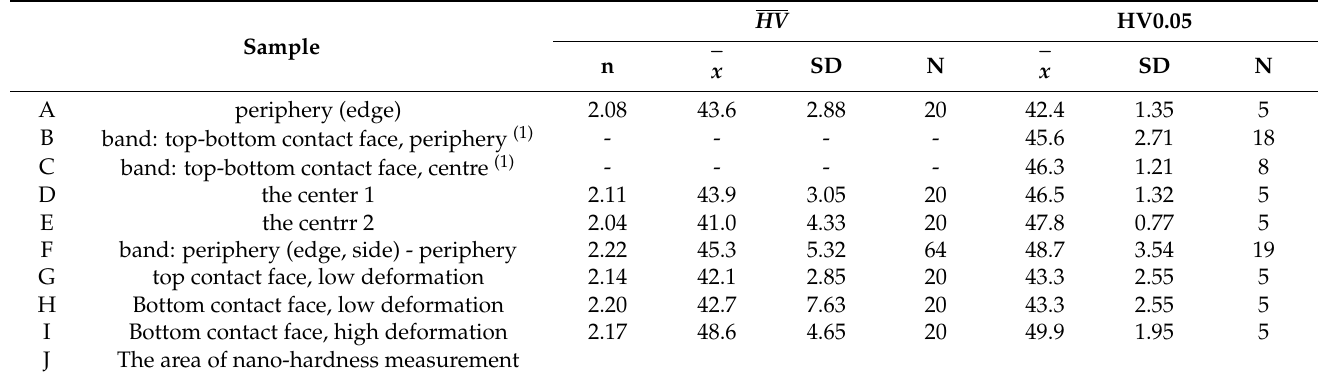
Table 3. Sample ε 10 . The values of Meyer’s index n, average micro-hardness x , the standard deviation of the hardness SD, and the number of the indentations N, the average micro-hardness at all four loads HV , and for the load 0.49035